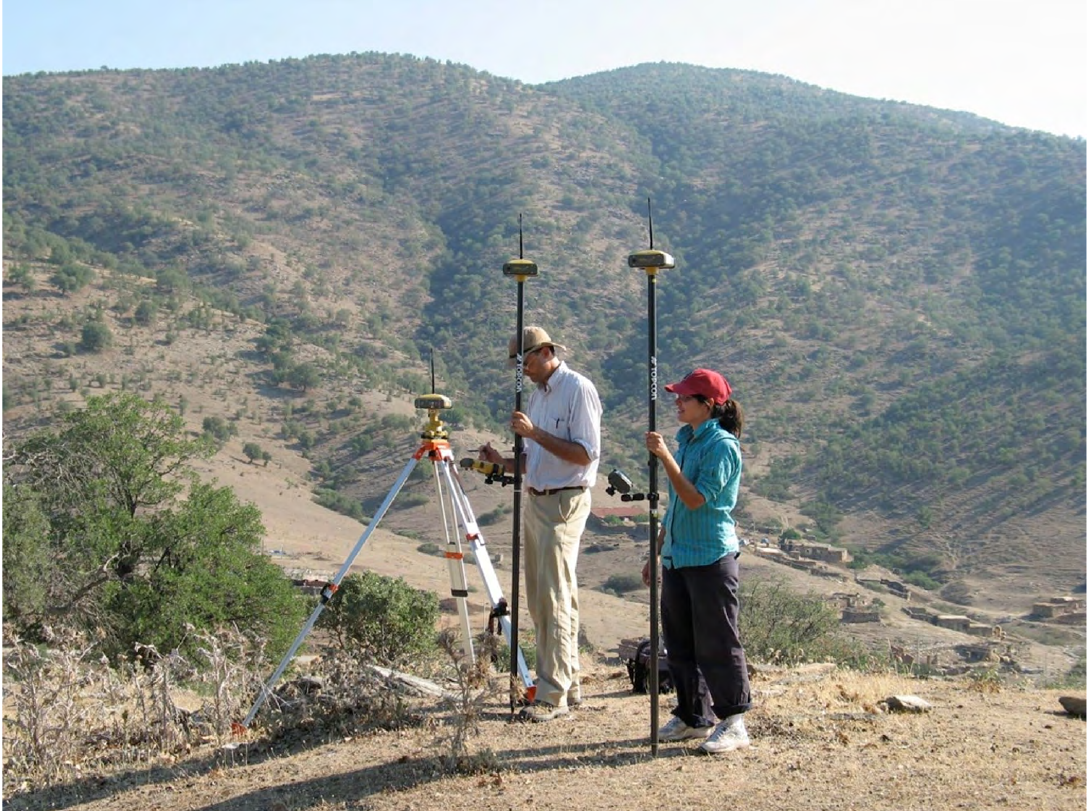
Figure 2: The Topcon RTK GNSS system, with base station, two rovers, data collectors, and